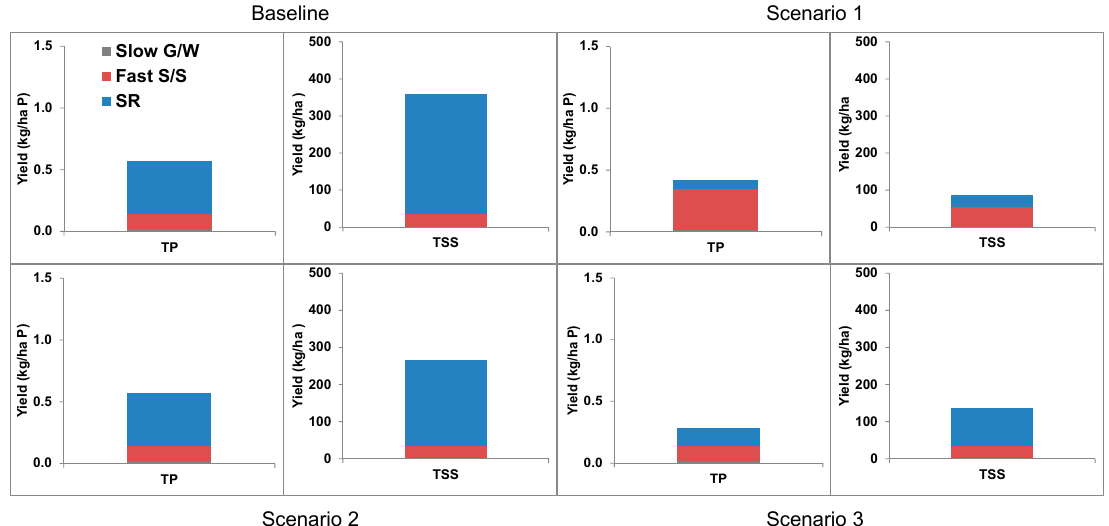
Figure 8. Plots showing modelled yields of TP and SS exported from the mitigated sub-catchment under all three scenarios in comparison with the modelled yields from the baseline.